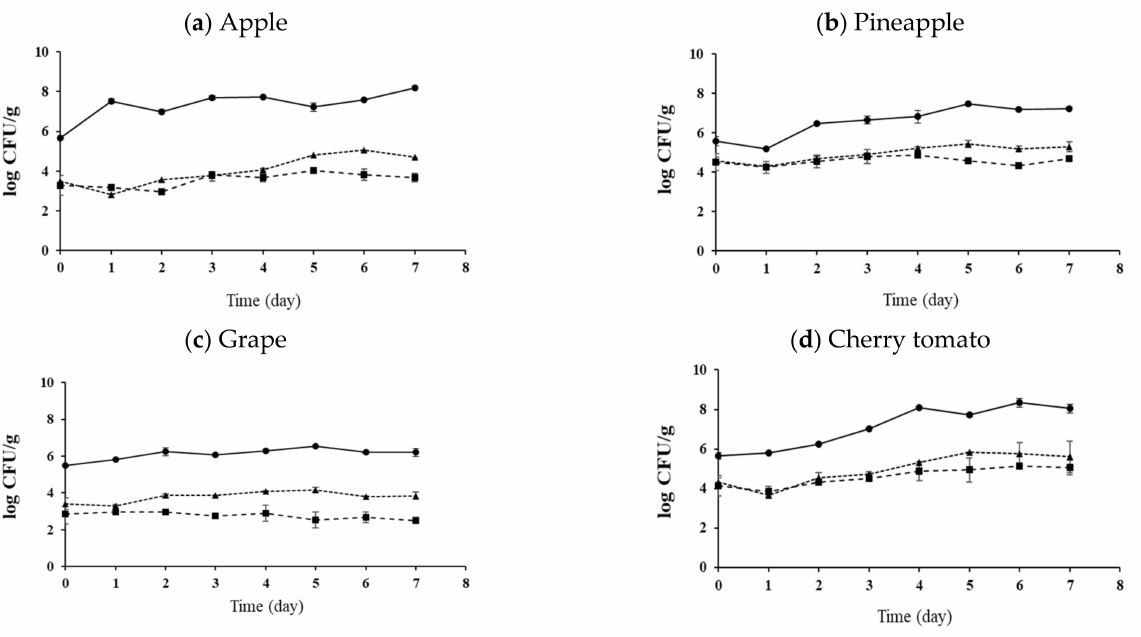
Figure 5. Change of L. monocytogenes population of ( a ) apple, ( b ) pineapple, ( c ) grape and ( d ) cherry tomato with disinfection treatments during storage at 15 ◦ C. Control, no extra wash with a sanitizer; SAEW, slightly acidic electrolyzed water; FA, fumaric acid; UVC- W LED, ultravioletC waterproof light-emitting diodes. Control ( • ), SAEW + FA ( (cid:78) ), SAEW + FA + UVC-W LED ( (cid:4)